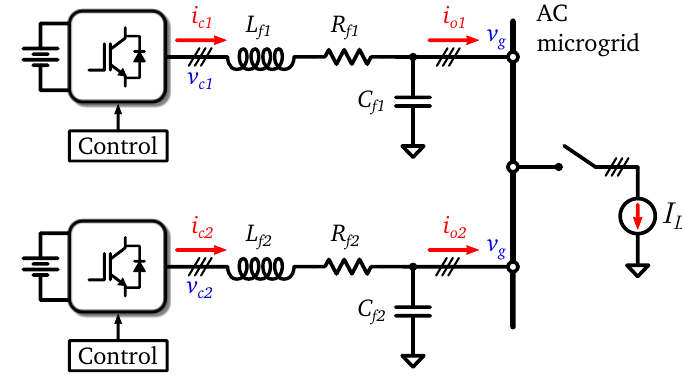
Figure 3. Simulation scenario for the validation of primary control strategies.